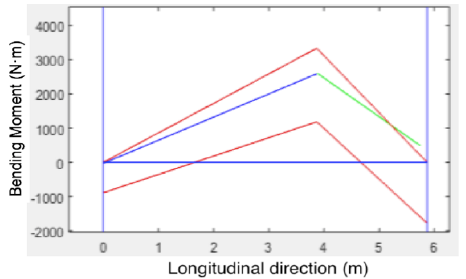
Figure 7. Bending moments for a concentrated load of 2000N, 2 m away from right end.